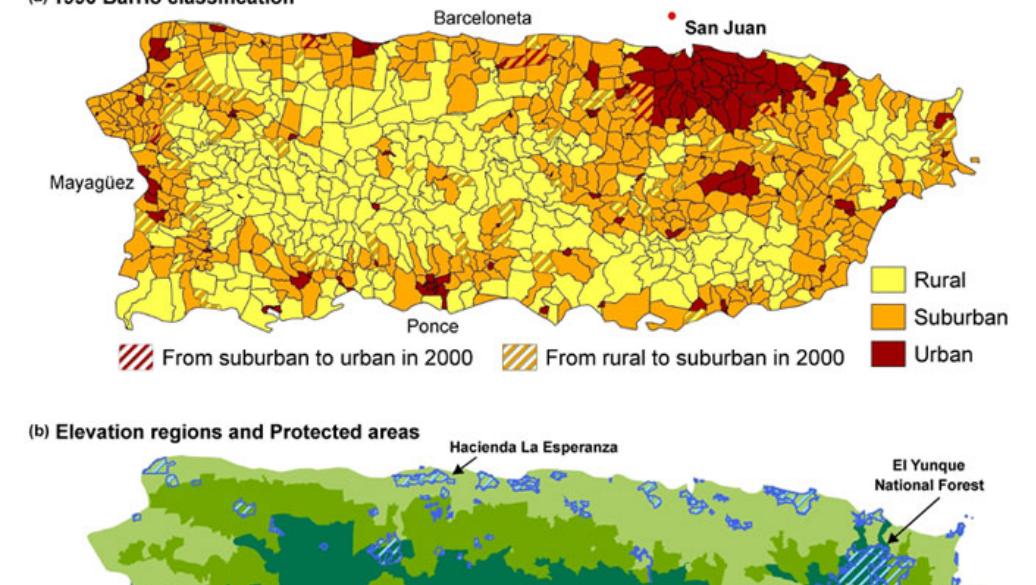
Fig. 1. Maps of Puerto Rico showing a) the 900 barrios classified by population density in 1990 into three classes (i.e., rural, suburban, urban), b) the three elevation regions, and c) land-use categories (modified from Gould et al.